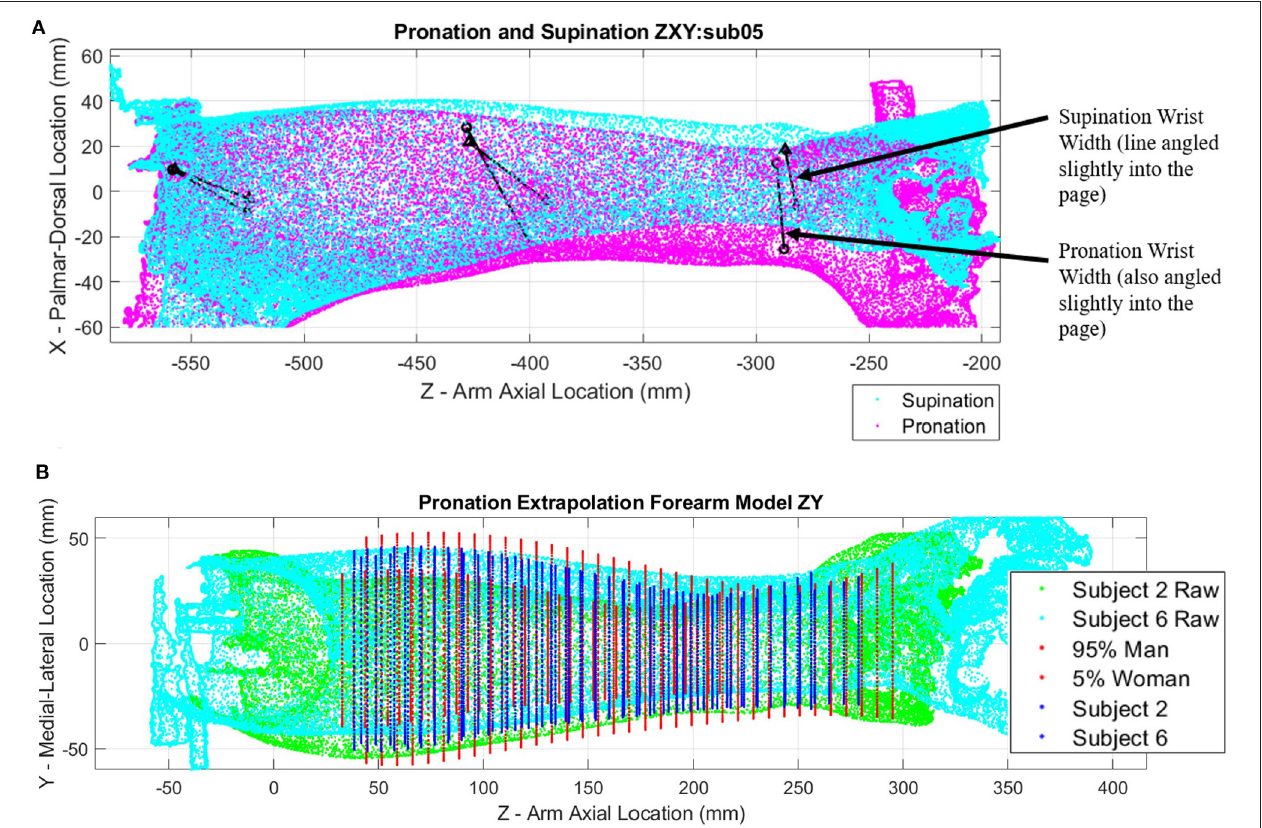
FIGURE 6 | Point clouds of arm scans and ellipse fit extrapolation modeling: (A) Pronation (magenta) and supination (cyan) point cloud poses with landmark target locations (black points) connected by black lines for subject 5; (B) Extrapolated models of forearms constructed with ellipses evenly spaced along forearm length for subjects 2 (green point cloud) and 6 (cyan point cloud), as well as a 5th percentile female and 95th percentile male for comparison.